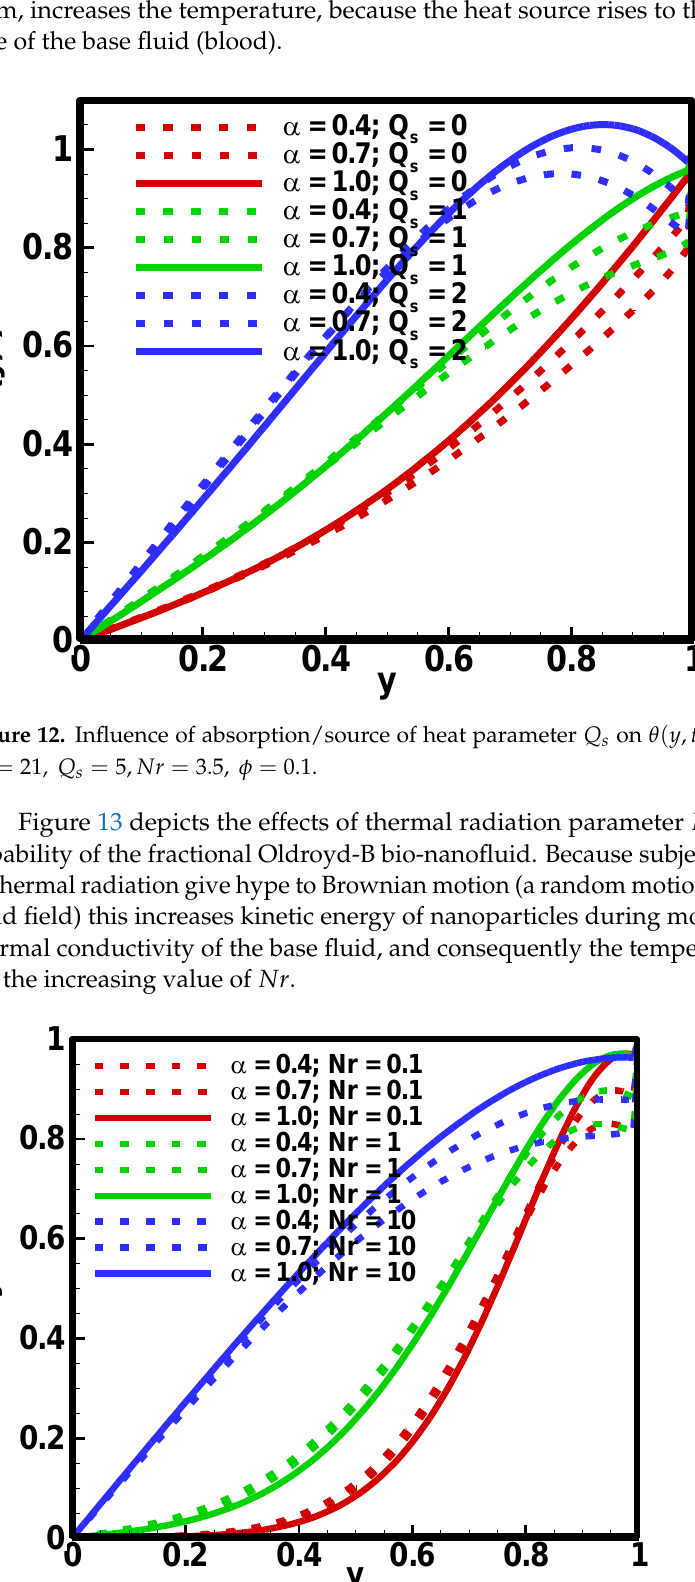
2𝛽 = 0.1, 𝑃𝑟 = 21, 𝑄 = 5, and 𝜙 = 0.1 . 𝑠